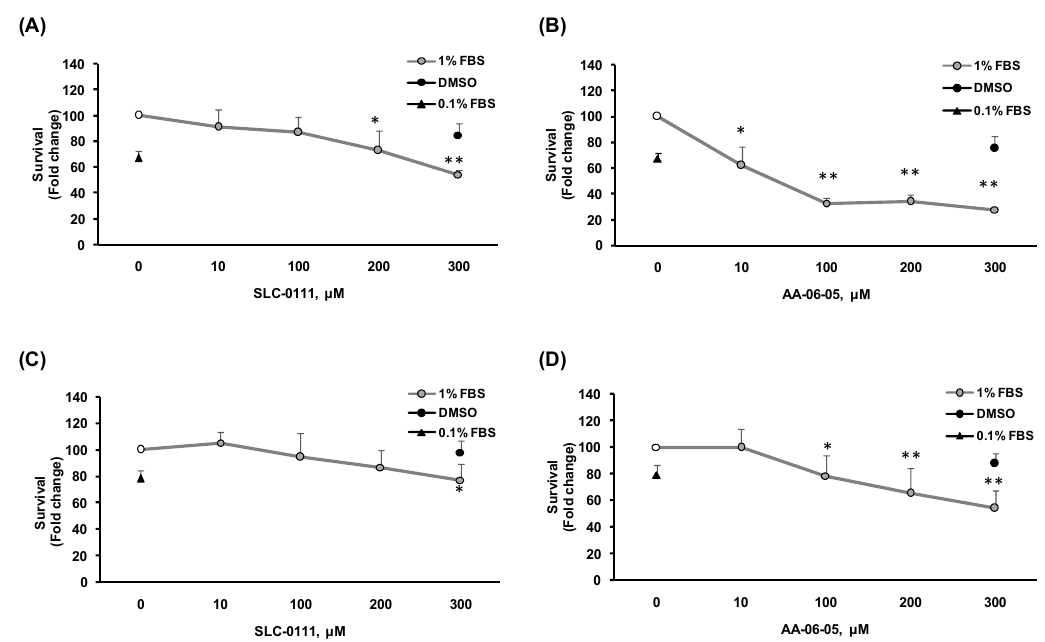
Figure 2. Survival curves of MDA-MB-231 and A549 cells exposed to CA-IX pharmacological inhibitors. MDA-MB-231 ( A , B ) and A549 ( C , D ) were treated with increasing concentrations [10–300 µ M] of SLC-0111 and AA-06-05for 48 h, under experimental condition of medium with 1% FBS. Survival data were calculated as 540 nm relative absorbance / well. Data in the graphs are reported as fold change (means ± SD), giving 100% to the control condition of 1 % serum. ( n = 3). * p < 0.05, ** p < 0.01 vs. untreated cells.